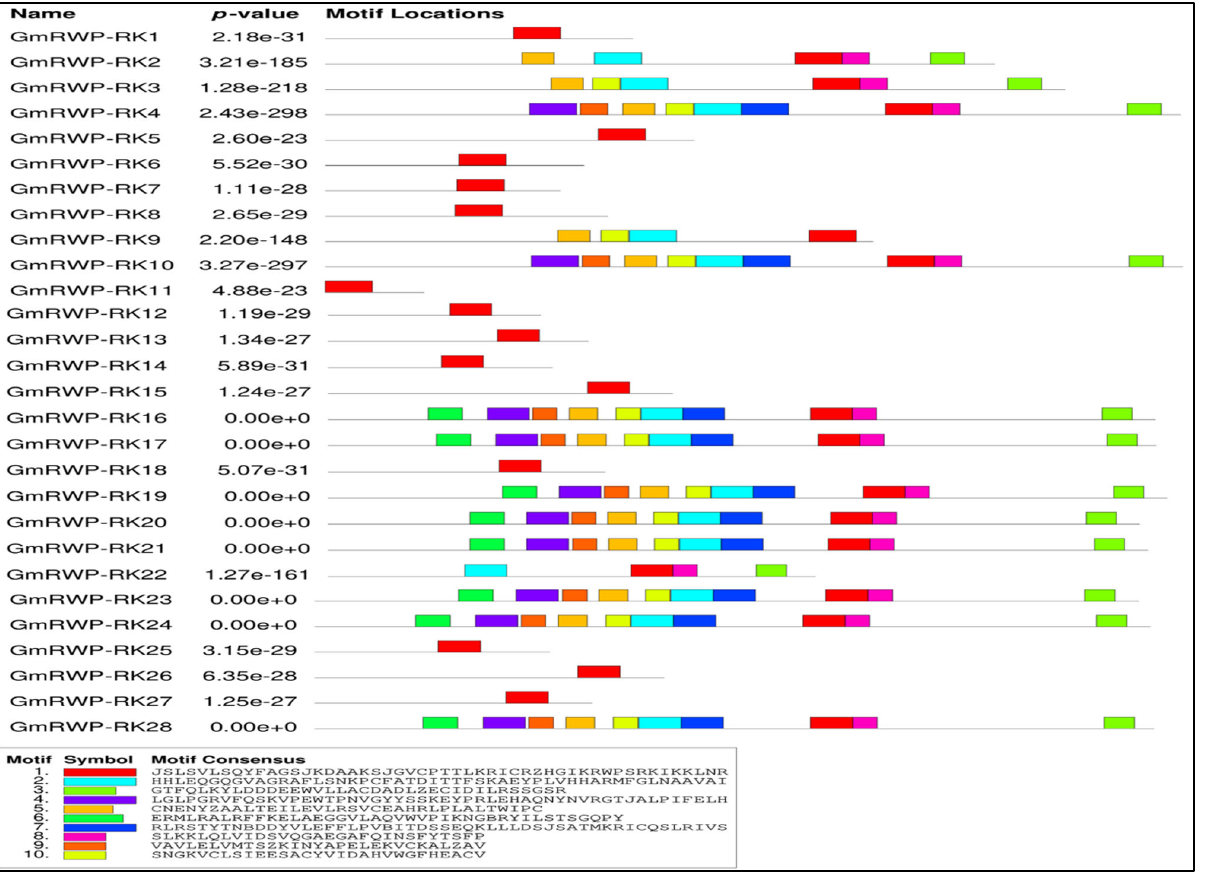
Figure 3. The distribution and organization of the conserved signature motifs of RWP-RK pro- teins in soybean. The protein motifs were analyzed in the MEME server using default parameters. The illustration of different motifs and their sequences are represented by different color boxes.